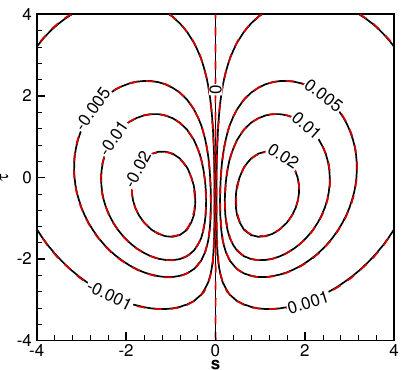
( s , τ ) , S = 2.0, T w / T = 1.5, α = 60 ◦ . Plate lengths 0 0 0 2 , d